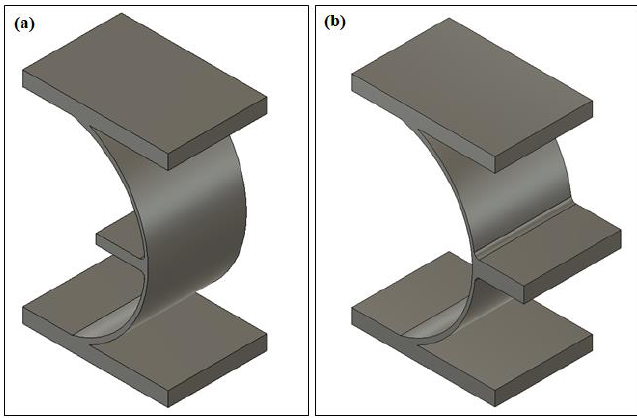
Figure 11. ( a ) Negative element, ( b ) positive element.